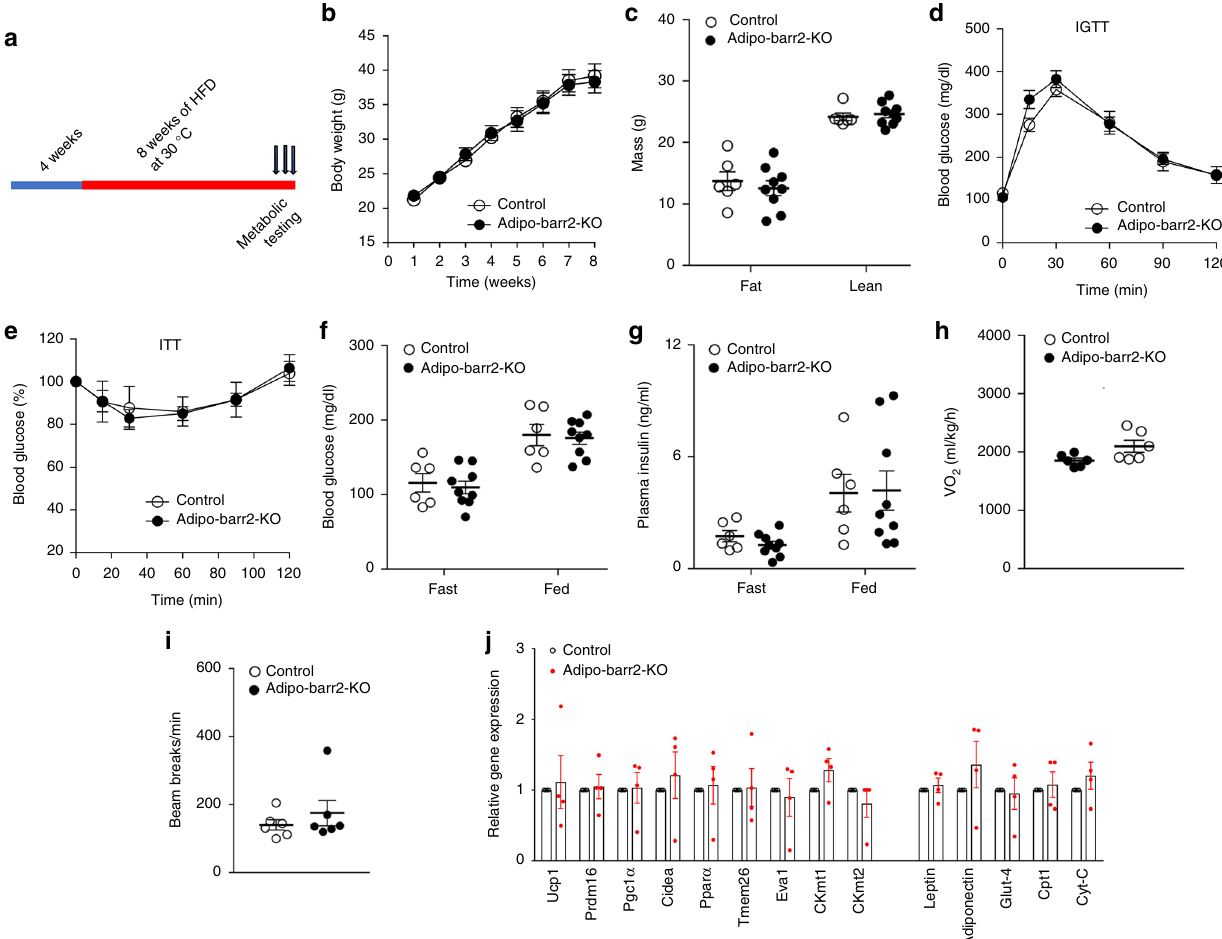
Fig. 4 HFD Adipo-barr2-KO mice show no metabolic changes at thermoneutrality. a Experimental time line. When control and adipo-barr2-KO mice reached 4 weeks of age, they were maintained on a HFD at thermoneutrality (30 °C). b Body weights of control and adipo-barr2-KO mice maintained on HFD at thermoneutrality ( n = 6 – 9 per group). c Body composition of mice fed with HFD for 8 weeks at thermoneutrality ( n = 6 – 9 per group). d I.p. glucose tolerance test (1 g glucose/kg; IGTT) carried out after 7 – 8 weeks of HFD feeding at thermoneutrality ( n = 6 – 9 per group). e Insulin tolerance test (1 U insulin/kg i.p.; ITT) performed after 7 – 8 weeks of HFD feeding at thermoneutrality ( n = 6 – 9 per group). f , g Freely fed and fasting blood glucose ( f ) and plasma insulin ( g ) levels measured after 7 – 8 weeks of HFD feeding at thermoneutrality ( n = 6 – 9 per group). h , i O 2 consumption rate ( h ) and ambulatory activity ( i ) at thermoneutrality after 7 – 8 weeks of HFD feeding ( n = 6 – 9 per group). j Relative transcript levels of browning/beiging marker genes and other key metabolic genes determined by qRT-PCR analysis of iWAT RNA after 7 – 8 weeks of HFD feeding at thermoneutrality ( n = 4 per group). All data are expressed as means ± s.e.m. Male mice were used for all the